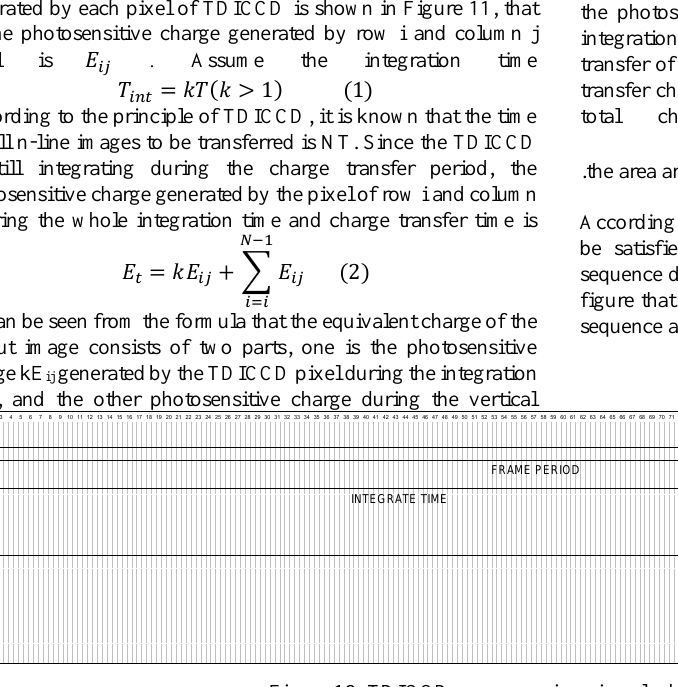
Figure 12. TDICCD area array imaging clock sequence